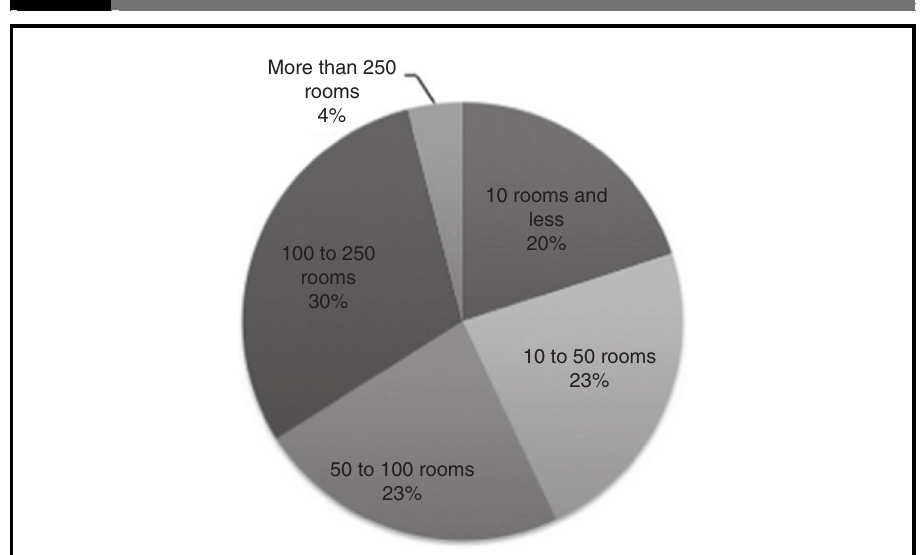
Figure 2 Distribution by size of the establishments represented by the study